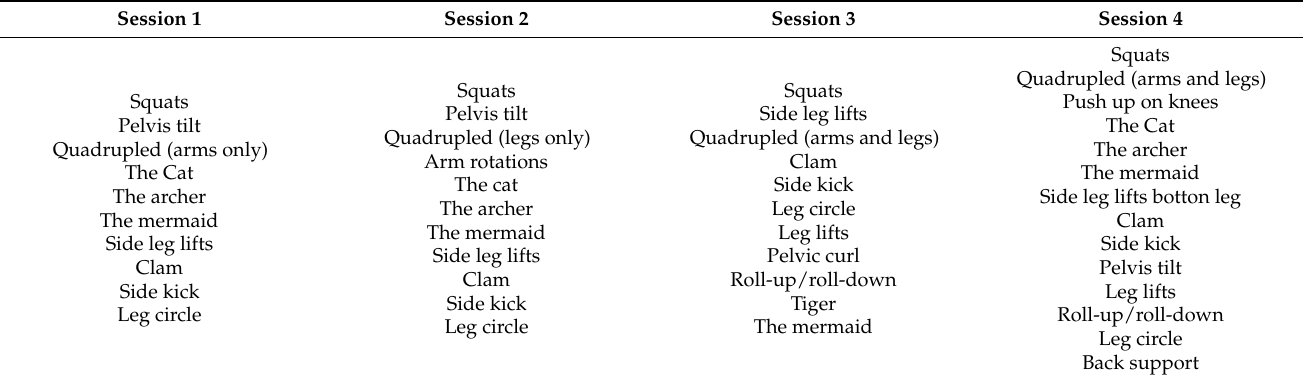
Table A1. Exercise Schedule of Pilates Method